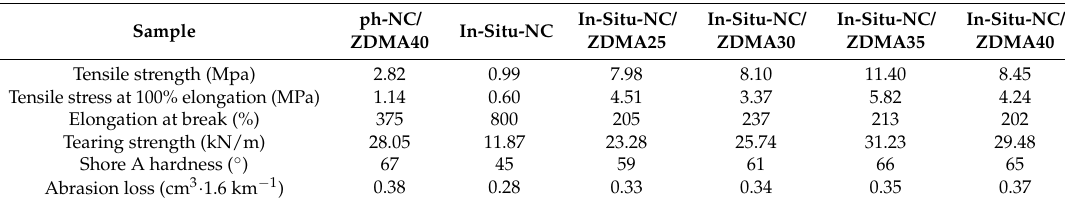
Table 1. Mechanical properties of in-situ-NC, in-situ-NC/ZDMAs, and ph-NC/ZDMA40.